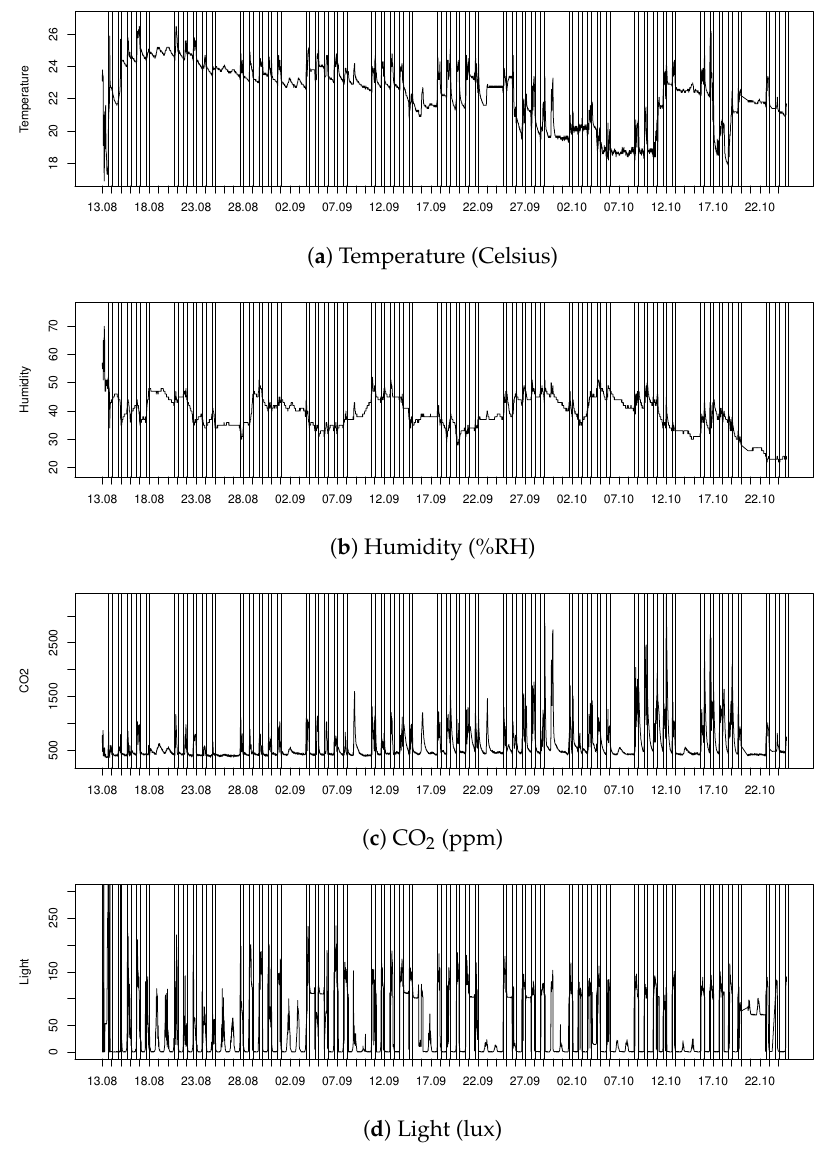
Figure 3. The seasonality in atmosphere measurement time series (work hours have been